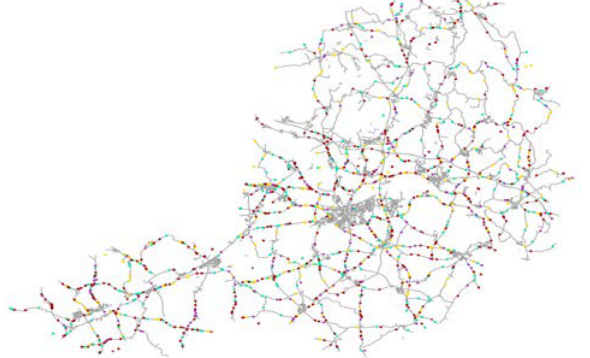
Figure 1. Spatial distribution of WVC in the county Straubing-Bogen Spatial distribution (Kernel Density) indicates some hot spots for WVC (Figure 2).